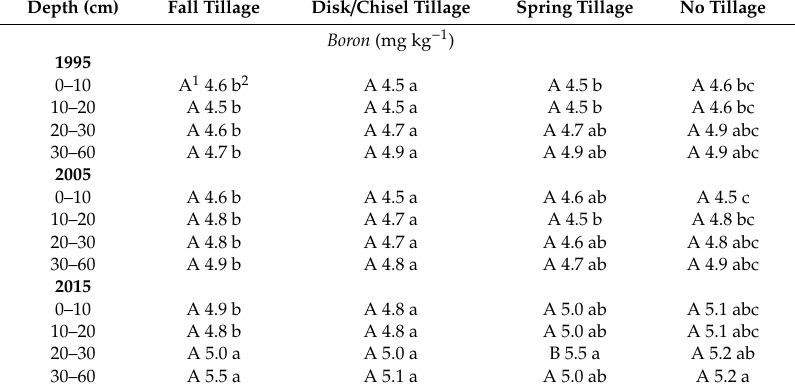
Table 2. Mean concentration of Mehlich III extractable boron obtained from the combinations of treatment, year and soil depth in the wheat–pea rotation long-term experiment (WP-LTE) at Pendleton.